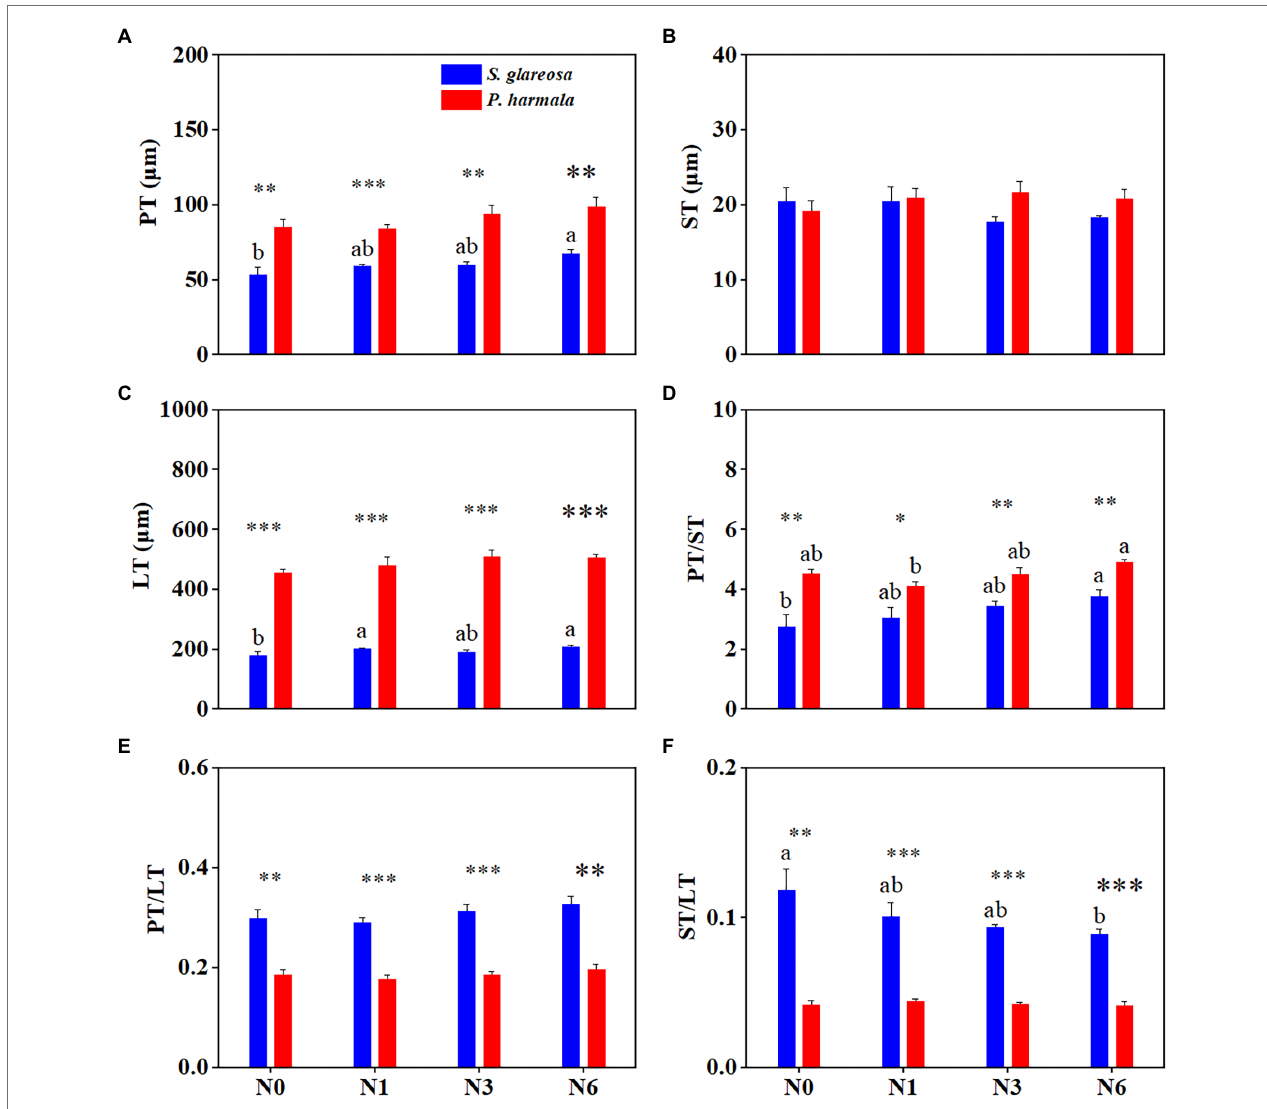
FIGURE 4 | Response of leaf anatomical traits in S. glareosa and P. harmala to different N treatments. (A) Palisade tissue thickness (PT), (B) spongy tissue thickness (ST), (C) leaf thickness (LT), (D) palisade–spongy tissue ratio (PT/ST), (E) palisade tissue–leaf thickness ratio (PT/LT), and (F) spongy tissue–leaf thickness ratio (ST/LT). Different lower-case letters represent significant differences among the treatments for each species ( p < 0.05). Asterisks represent significant differences between S. glareosa and P. harmala (* p < 0.05; ** p < 0.01; and *** p <